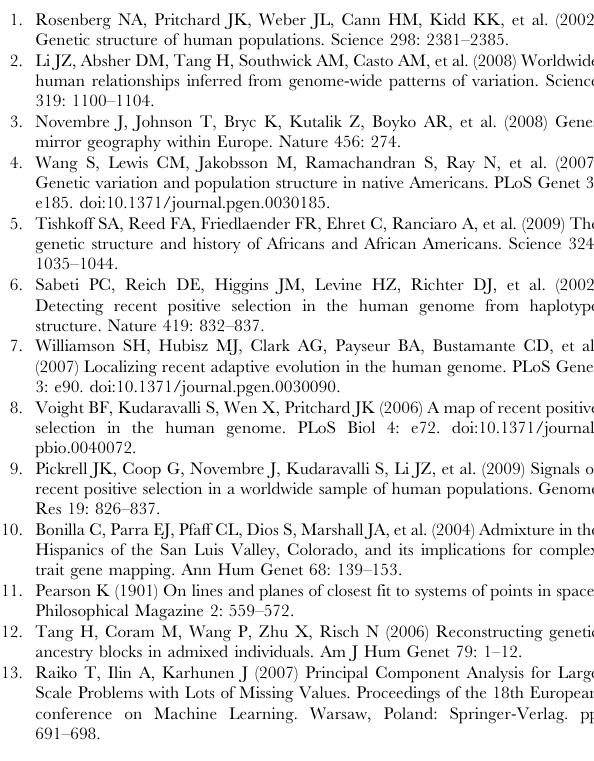
ancestry across all markers: yellow = Indigenous American, red =European, blue = African. (TIFF) Figure S2 Simulation experiments for assessing the robustness of ssPCA in the presence of uncertainty associated with the inference of locus-specific ancestry. The mean confusion fraction for separating Northern and Southern European substructure (y-axis, averaged over 10 independently simulated datasets) increases with the error rate in the putative virtual genome (x-axis). Arrow indicates the mean confusion fraction when ssPCA is applied to virtual genomes inferred using SABER + ( j =1.58%). (TIFF) Figure S3 PC1 versus PC3 separate Mex AMR from Pima individuals. (TIFF) Table S1 Individuals and markers used for analyses.